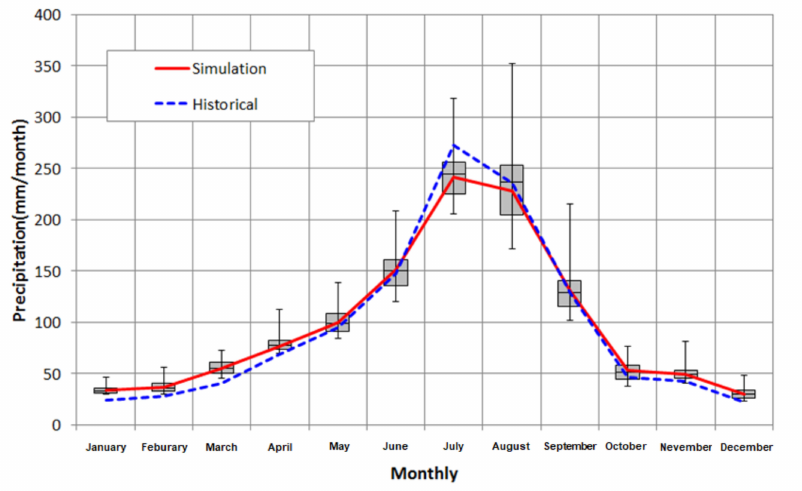
Figure 9. Variability for monthly